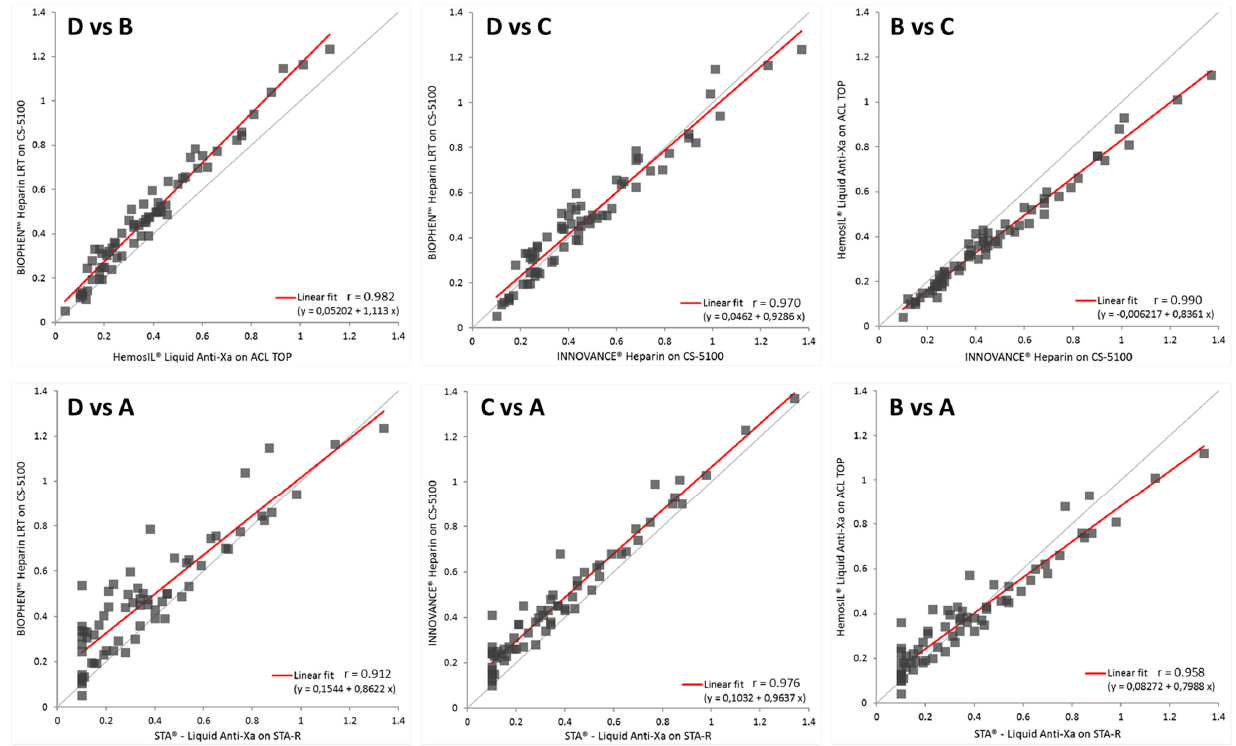
Figure 2. Shows the global Pearson’s cross-correlations among the 4 different branded anti-FXa assays for all the tested plasma samples from heparin treated patients (either with UFH or LMWH), and anticoagulated with citrate or CTAD. Assays for reagents B (IL), C (Siemens), and D (Hyphen BioMed) contain dextran sulfate, whilst the assay for reagent A (Diagnostica Stago) does not. The global ordinary least square correlation coefficient “ r ” is closer to 1.00, when assays containing dextran sulfate are compared between them.